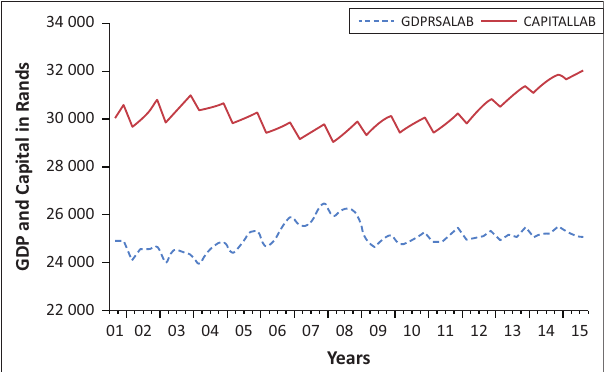
FIGURE 9: Co-movement of seasonal adjusted provincial gross domestic product per skill adjusted labour supply and seasonal adjusted fixed provincial government capital stock per skill adjusted labour supply (Rand).